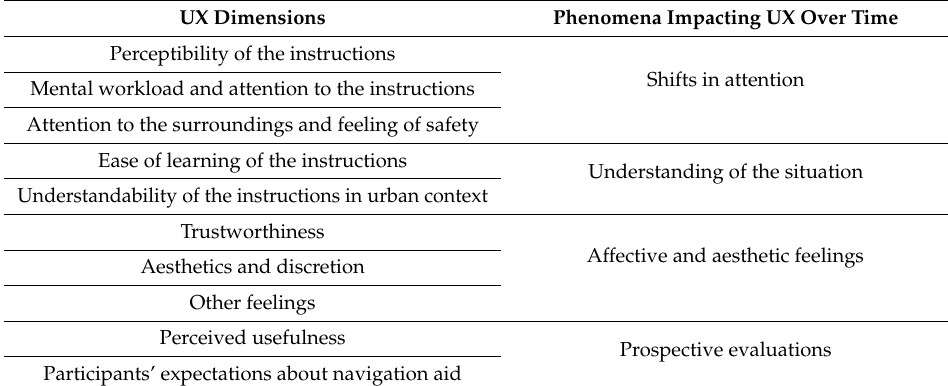
Table 1. User experience (UX) dimensions and phenomena highlighted from the analysis of the participants’ interviews and the